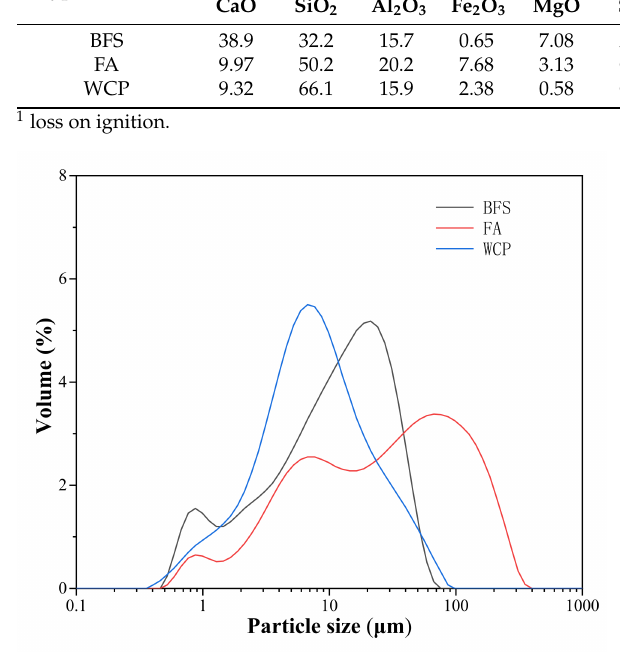
Figure 1. Particle size distribution of BFS, FA, and WCP.